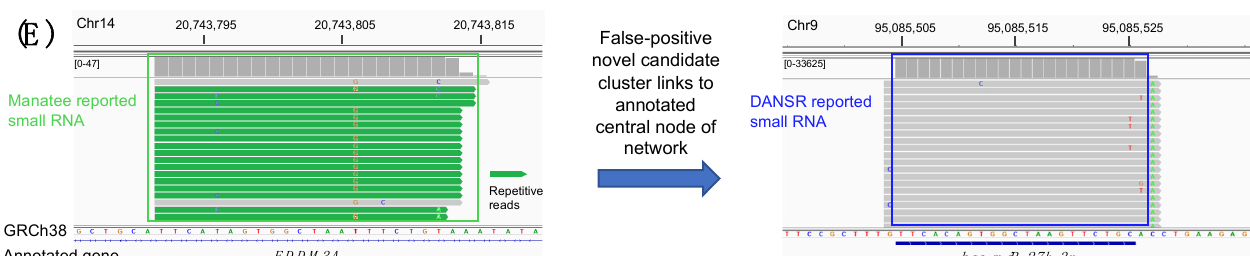
Figure 5. Benchmarking using contemporary small RNA discovery tools. ( A ) Number of unique clusters of each small RNA species and novel, unannotated clusters identified within the primary colon tumor samples of the deep-sequenced CRC cohort by DANSR, Manatee, and ShortStack. Annotated and novel clusters discovered by DANSR are plotted in dark blue; clusters discovered by Manatee that were not rejected by DANSR are plotted in dark green, while clusters reported by Manatee that were rejected by DANSR for failing to pass quality filters (clusters of repetitive reads containing no reads with a unique mapping, clusters that share most reads with a better quality cluster at another genomic location, clusters representing expression of protein coding genes, etc.) are plotted in light green; clusters discovered by ShortStack that were not rejected by DANSR are plotted in dark red, clusters that failed DANSR’s quality filters in light red. ( B ) Benchmarking results for each tool on a set of simulated ncRNA read data; true positives (TP) are in blue, false negatives (FN) in green, and false positives (FP) in red. ( C ) DANSR demonstrates the best overall performance in detecting simulated small RNAs as determined by F1 score. A false negative is a case in which a small RNA with simulated transcript count >5 was estimated as 0 by a tool; a false positive is a case in which a tool estimates transcript counts >5 for which the true value was 0. ( D ) Manatee reports as novel small RNA discoveries over 1,900 clusters that DANSR correctly identifies and rejects as expression from protein coding genes, an example of which is seen here. ( E ) Manatee reports as results over 15,000 clusters that fail to pass DANSR’s QC filters, including over 400 with significant